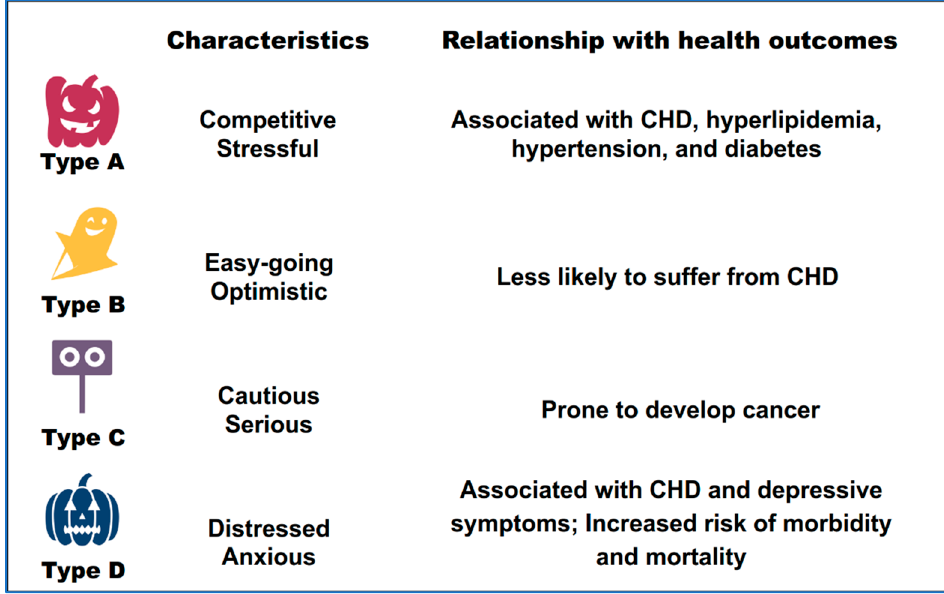
Figure 1. Personality types A, B, C, and D and their relationships with health outcomes. CHD: coronary heart disease.